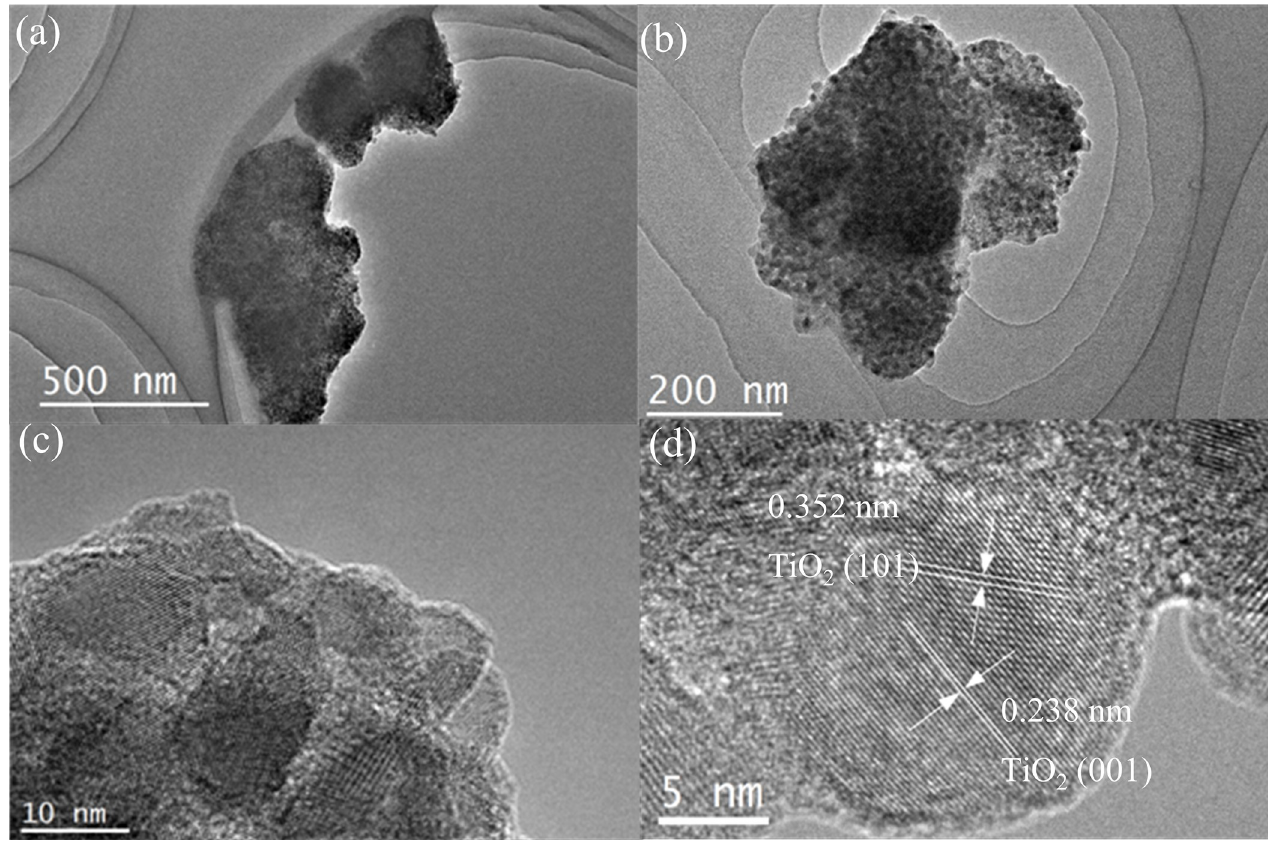
Fig 3. TEM (a, b) and HRTEM (c, d) images of